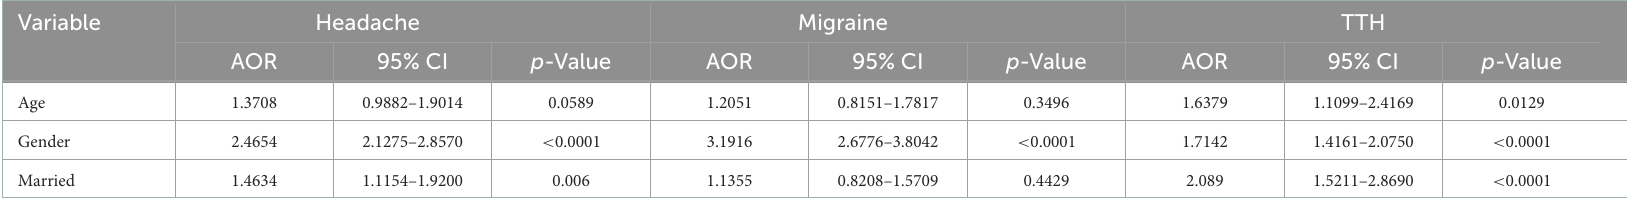
TABLE 6 Multivariate logistic regression analysis for association with sociodemographic